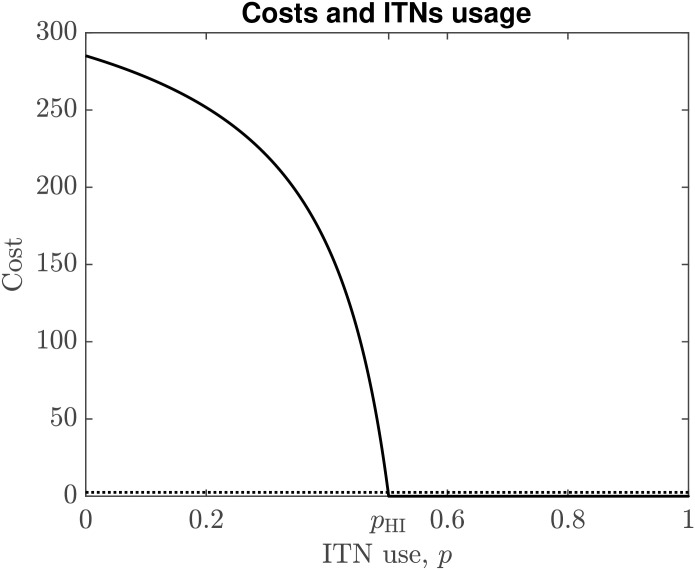
The expected cost of not using ITN (solid) as a function of ITNs use in the population.Parameters are as in Table 1. Herd immunity is achieved when the expected cost reaches 0. The Nash equilibrium ITN use is achieved at the intersection with the dotted line (the cost of the ITN). It follows that pNE < pHI, but also pNE ≈ pHI.